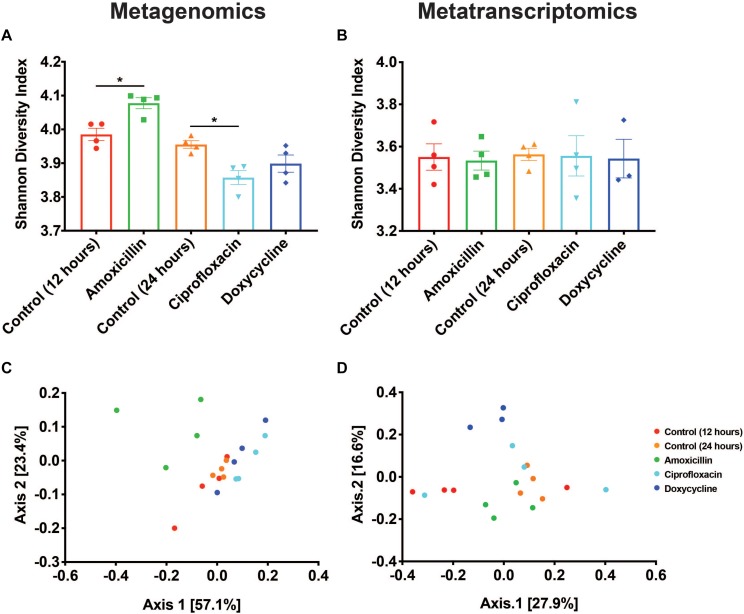
Antibiotics have variable impacts on the diversity and structure of the resistome. (A,B) Shannon diversity index based on resistance gene counts displayed as mean ± SEM for both metagenomic and metatranscriptomic data (*p < 0.05 Mann-Whitney U test). (C,D) PCoA based on Bray-Curtis of resistance gene counts for both metagenomic and metatranscriptomic data.